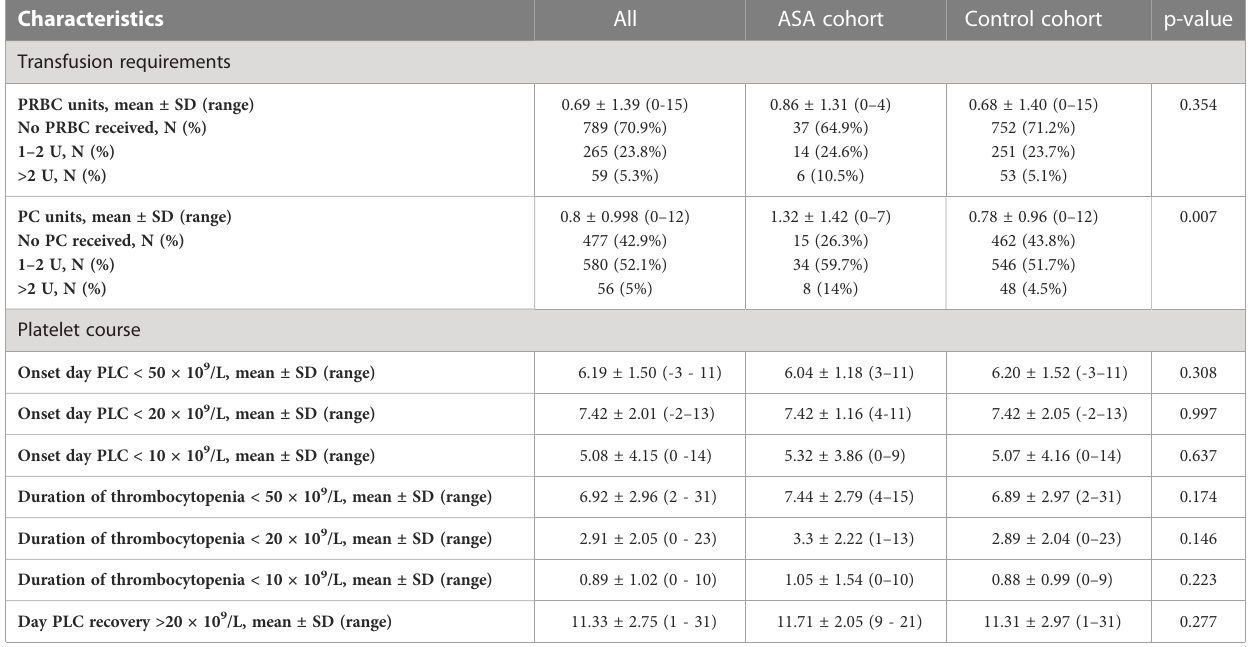
TABLE 2 Transfusion requirements, onset, and duration of thrombocytopenia. Characteristics